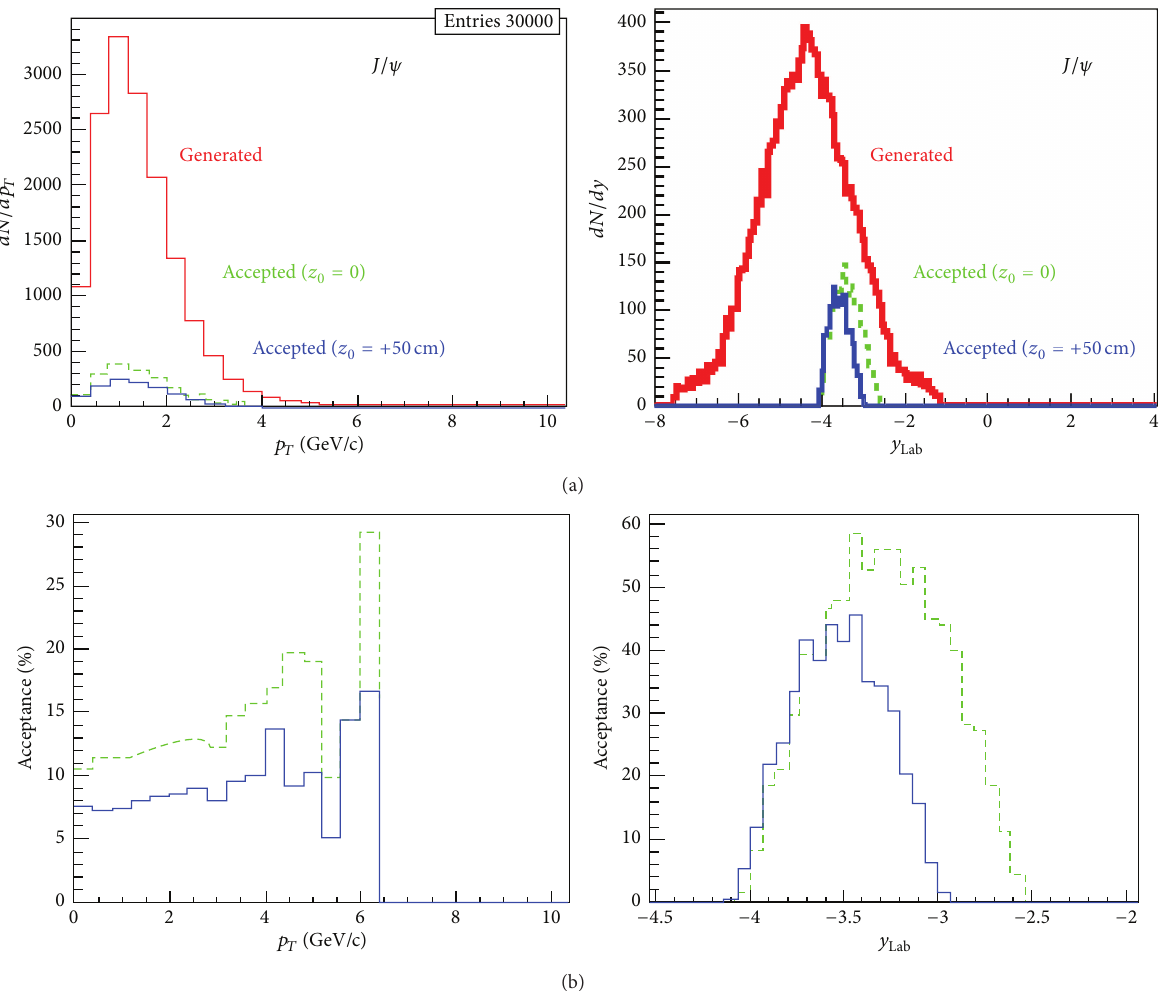
Figure 8: Transverse momentum and rapidity distributions for 𝐽/𝜓 events, produced at 𝑧 = +50 cm (solid lines) and 𝑧 = 0 (dashed lines) in